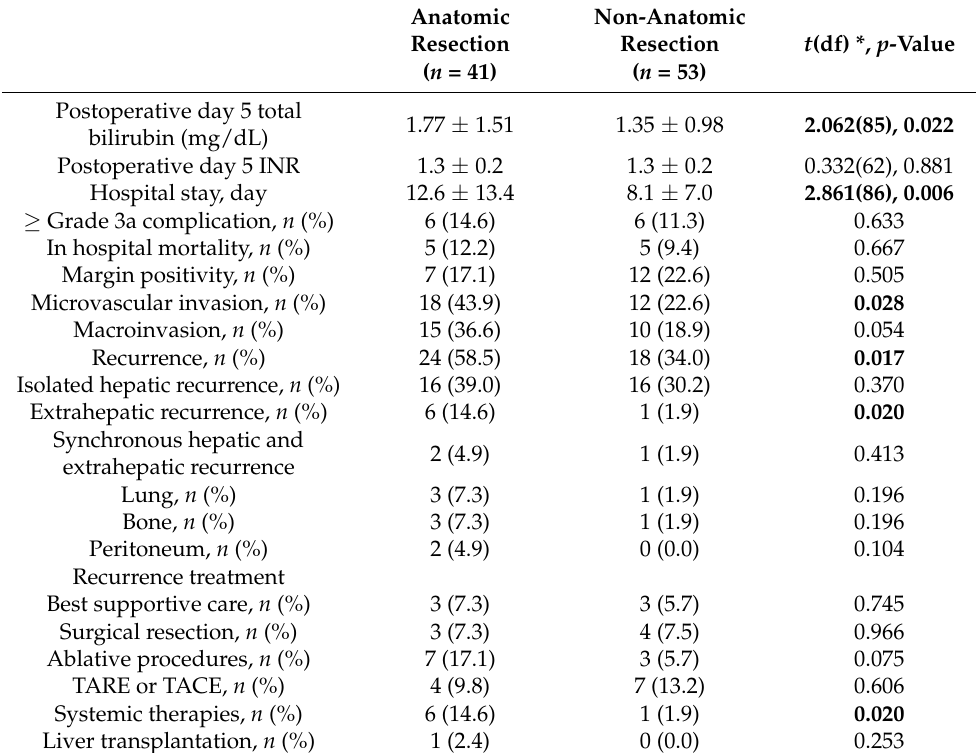
Table 2. Postoperative outcomes, with comparisons between patients who underwent anatomic and non-anatomic resections.